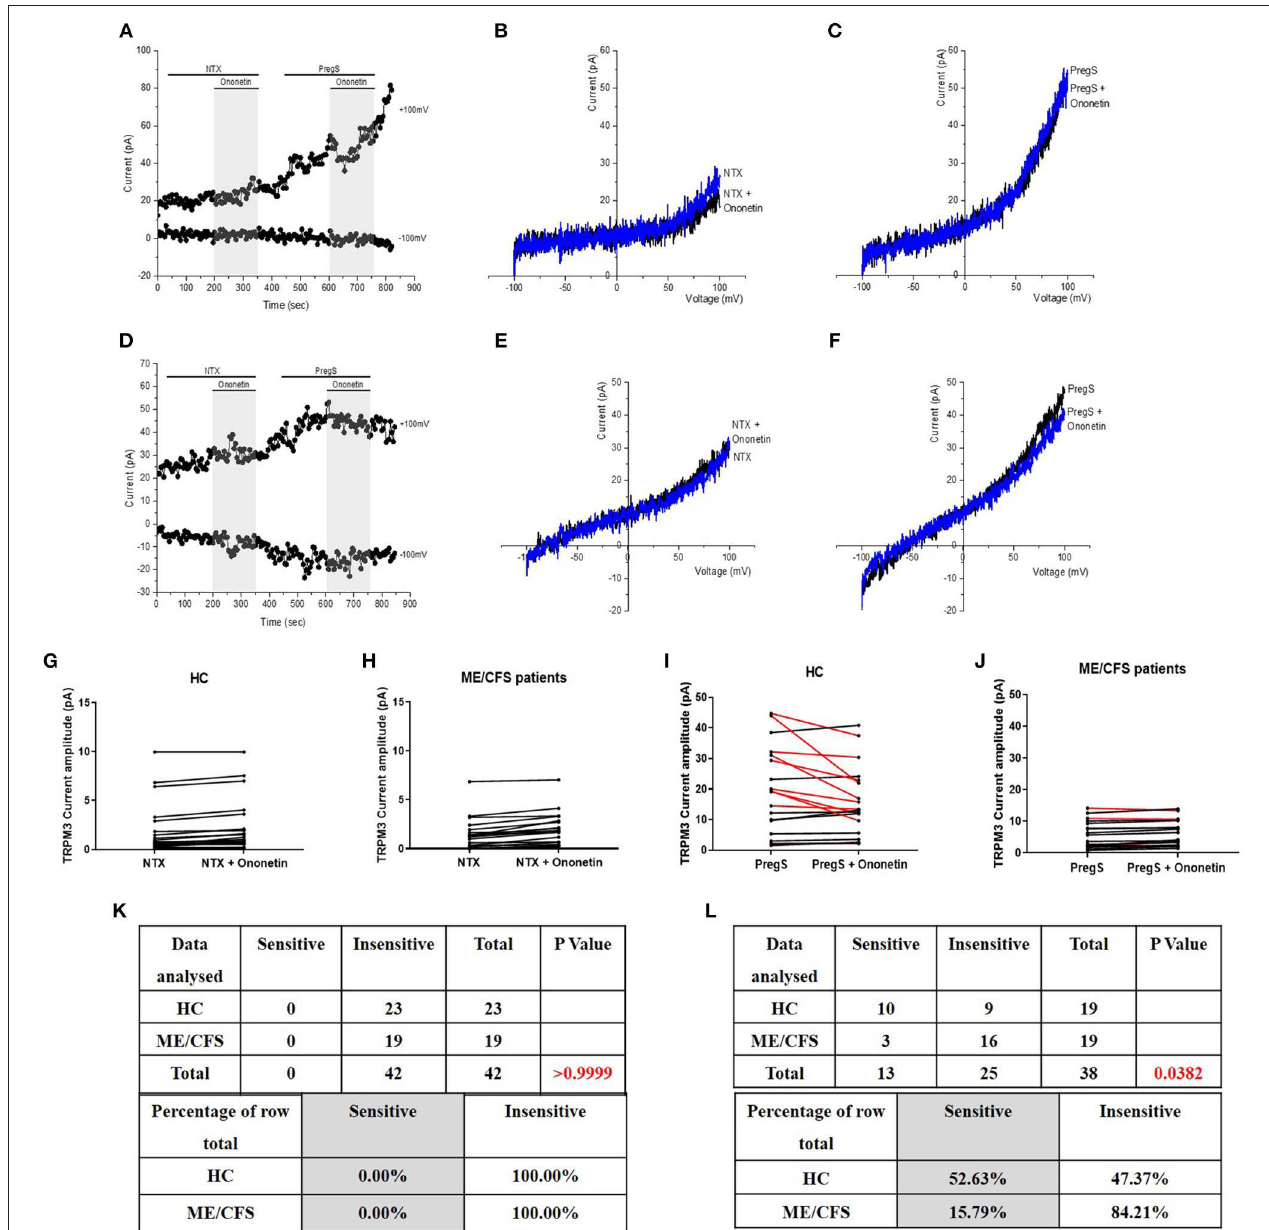
FIGURE 7 | Modulation of NTX- and PregS- evoked currents with Ononetin. Data were obtained under whole-cell patch clamp conditions. (A) A representative time-series of current amplitude at + 100mV and − 100mV showing the effect of 10 µ M ononetin (gray) on ionic currents in the presence of 200 µ M NTX or 100 µ M PregS in IL-2 stimulated NK cells from HC. (B) I – V before and after application of ononetin in the presence of NTX in a cell as shown in (A). (C) I – V before and after application of ononetin in the presence of PregS in a cell as shown in (A). (D) A representative time-series of current amplitude at + 100mV and − 100mV showing the effect of 10 µ M ononetin (gray) on ionic currents in the presence of 200 µ M NTX or 100 µ M PregS in IL-2 stimulated NK cells ME/CFS patients. (E) I – V before and after application of ononetin in the presence of NTX in a cell as shown in (D) . (F) I – V before and after application of ononetin in the presence of PregS in a cell as shown in (D). (G,H) Scatter plots representing change of each current amplitude before and after application of ononetin in presence of NTX in all NK cells from HC and ME/CFS patients. Each cell represented as red lines had reduction in currents by ononetin. (I,J) Scatter plots representing change of each current amplitude before and after application of ononetin in presence of PregS in all NK cells from HC and ME/CFS patients. Each cell represented as red lines had reduction in currents by ononetin. (K) Table summarizing data for sensitive and insensitive cells to 10 µ M ononetin in presence of NTX in HC ( N = 8; n = 23) compared to ME/CFS patients ( N = 8; n = 19). (L) Table summarizing data for sensitive and insensitive cells to 10 µ M ononetin in presence of PregS in HC ( N = 8; n = 19) compared to ME/CFS patients ( N = 8; n = 19). Data are analyzed with Fisher’s exact test. ME/CFS, myalgic encephalomyelitis/chronic fatigue syndrome; HC, healthy controls; NK, natural killer; NTX, naltrexone hydrochloride; PregS, Pregnenolone sulfate; TRPM3, Transient Receptor Potential Melastatin 3.